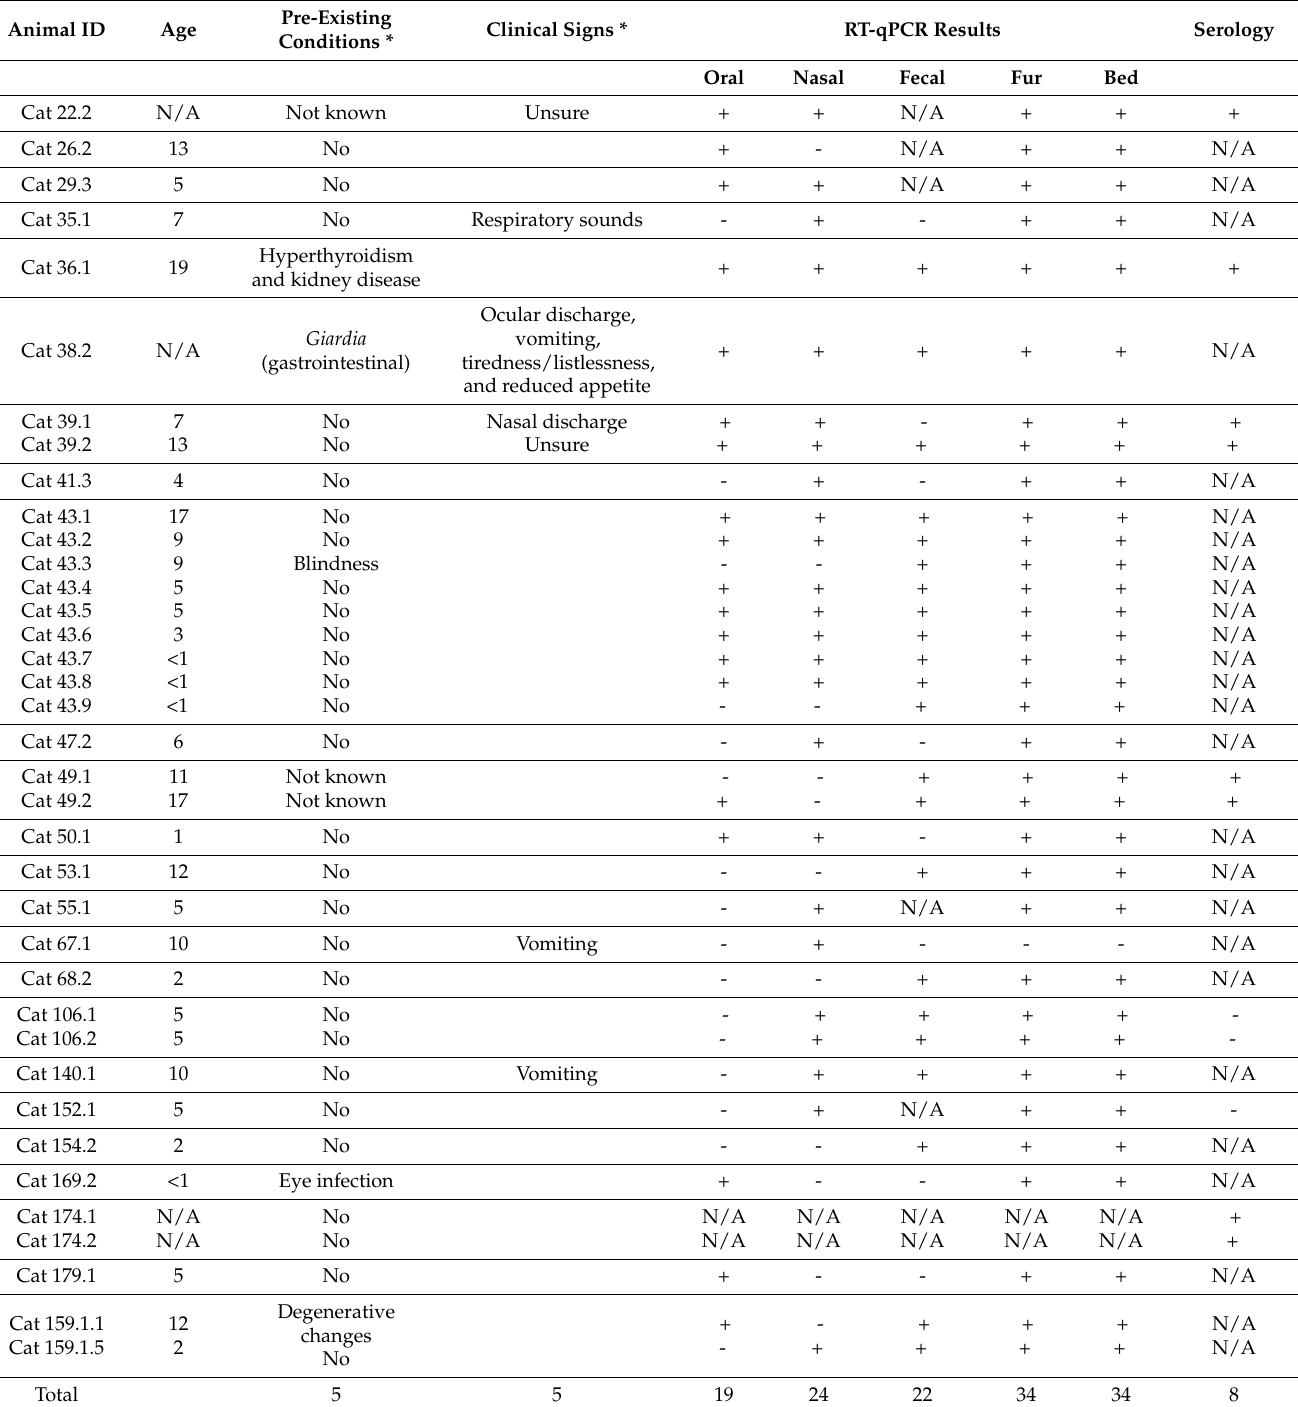
Table 1. Overview of the 37 SARS-CoV-2-positive cats: their ages, pre-existing conditions, clinical signs, RT-qPCR results from different samples, and serology